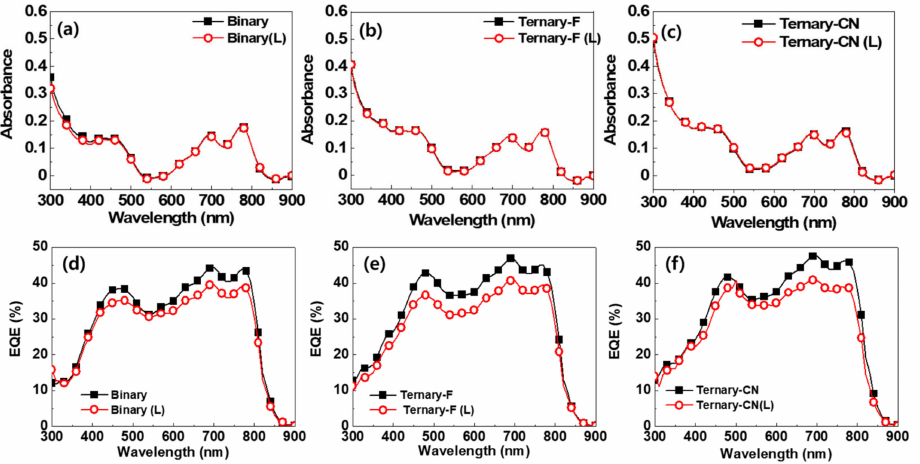
Figure 4. Comparison of the absorption spectra ( a – c ) and EQE spectra ( d – f ) of Binary, Ternary-F, and Ternary-CN before and after the light-soaking